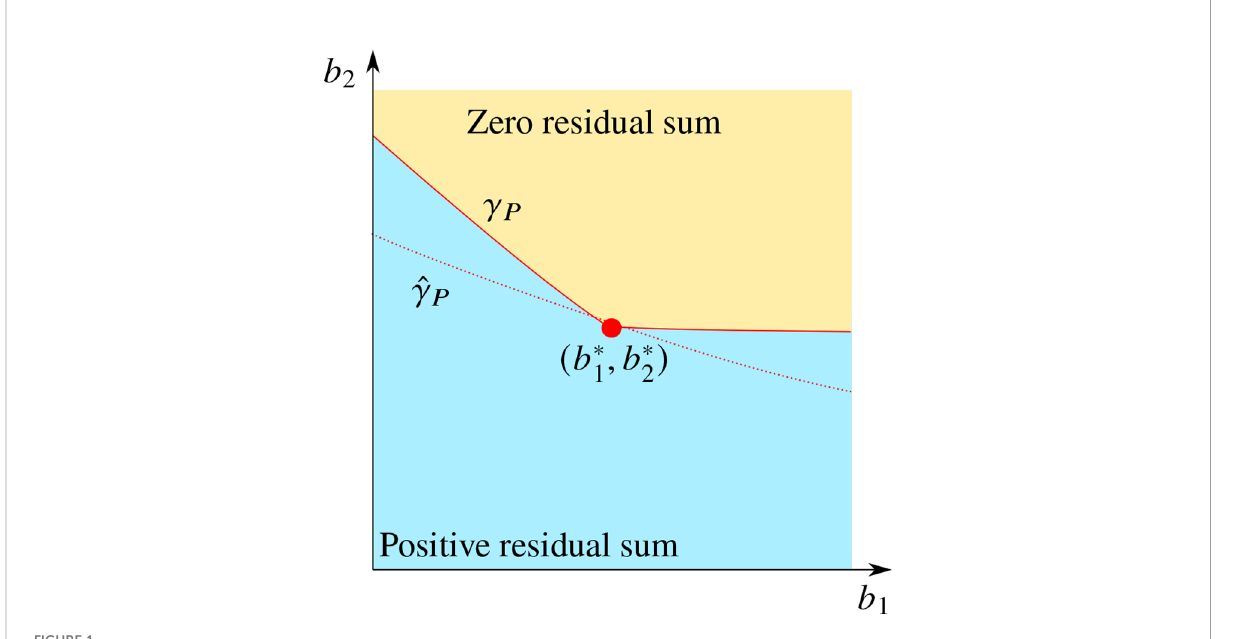
FIGURE 1 Illustration of the qualitative behavior of the curve g P (red solid line) and its estimate ^ g P (red dotted line) in the b 1 - b 2 -parameter space, in relation to the true parameter values ( b * 1 , b * 2 ) (red